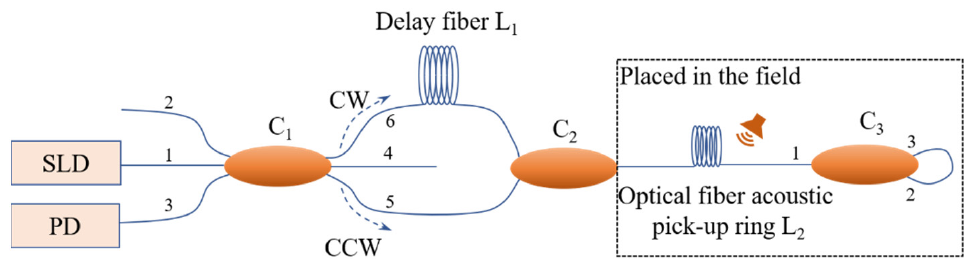
Figure 1. The schematic of the straight line-type Sagnac fiber optic acoustic sensing system.